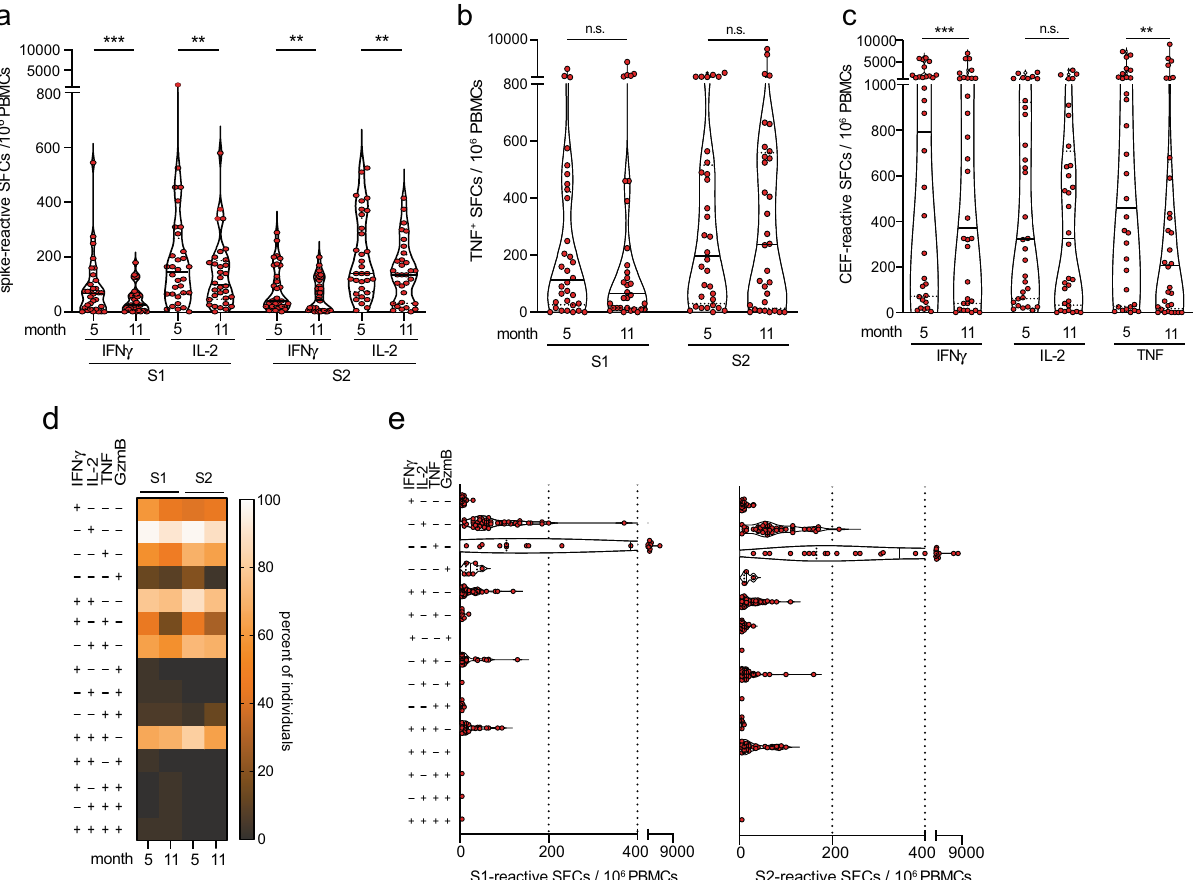
Fig. 4 Persistence of polyfunctional S1- and S2-reactive IFN γ - and IL-2-secreting cells up to 11 months after SARS-CoV-2 infection. ( a , b ) frequencies of spike-reactive cytokine-secreting cells in convalescents ( n = 32) at month 5 and month 11 after SARS-CoV-2 infection. c Frequencies of CEF-reactive cytokine-secreting cells in convalescents ( n = 32) at month 5 and month 11 after SARS-CoV-2 infection. d Heatmap revealing frequencies of convalescents bearing S1-reactive mono- or polyfunctional cytokine-secreting cells at month 5 and month 11 after SARS-CoV-2 infection. e Fluorospot analysis revealing the frequencies of spike-reactive mono- and polyfunctional cytokine-secreting cells (SFCs per 10 6 PBMCs) from convalescents ( n = 49) at month 11 after SARS-CoV-2 infection. Statistical analyses by two-sided Wilcoxon signed-rank tests ( a – c , e ); n.s. denotes not signi fi cant; ** p < 0.01; *** p < signi fi cant difference between convalescent and naïve individuals (Fig. 5a – c, Supplementary Fig. 6a – c), indicating a synchroniza- tion of spike-speci fi c immune responses in convalescents and more cytokines remained constant (Fig. 4d, e), consistent with naïve individuals through BNT162b2 mRNA vaccination. sustained and functional virus-speci fi c memory T cell immunity